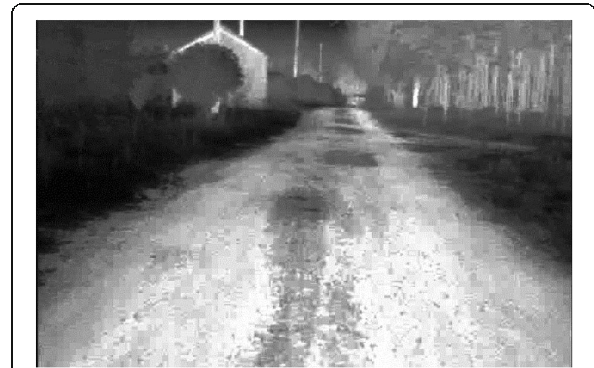
Fig. 2 Image after histogram